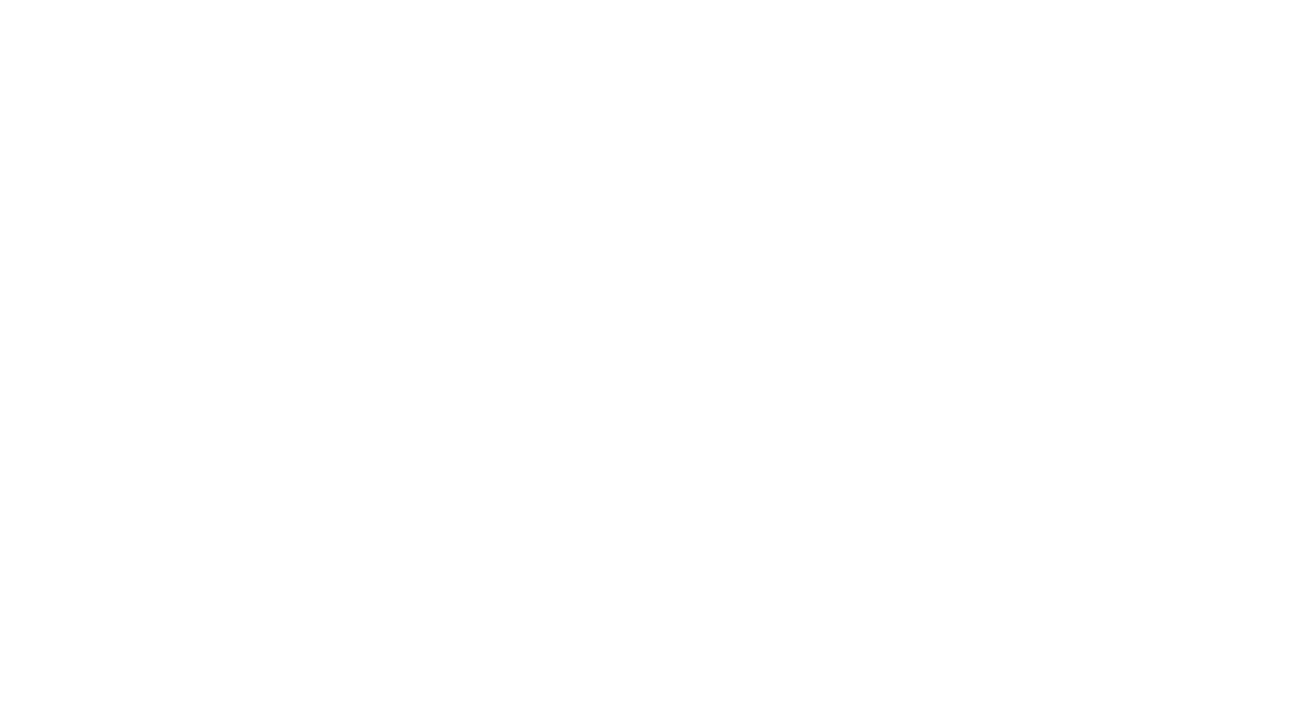
Frontiers in Microbiology |